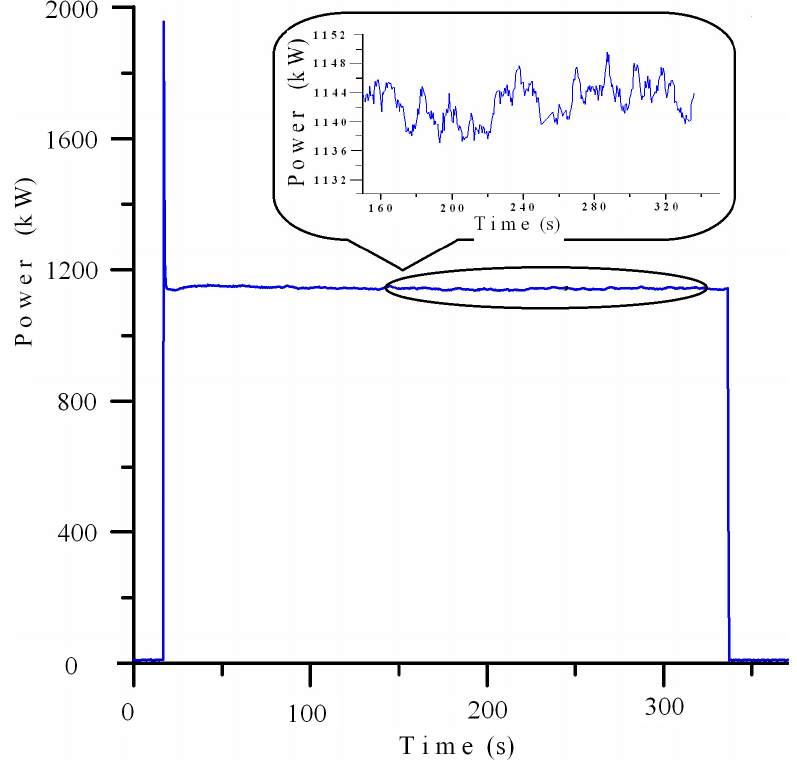
Figure 3. Real power waveform of a 1200 W vacuum